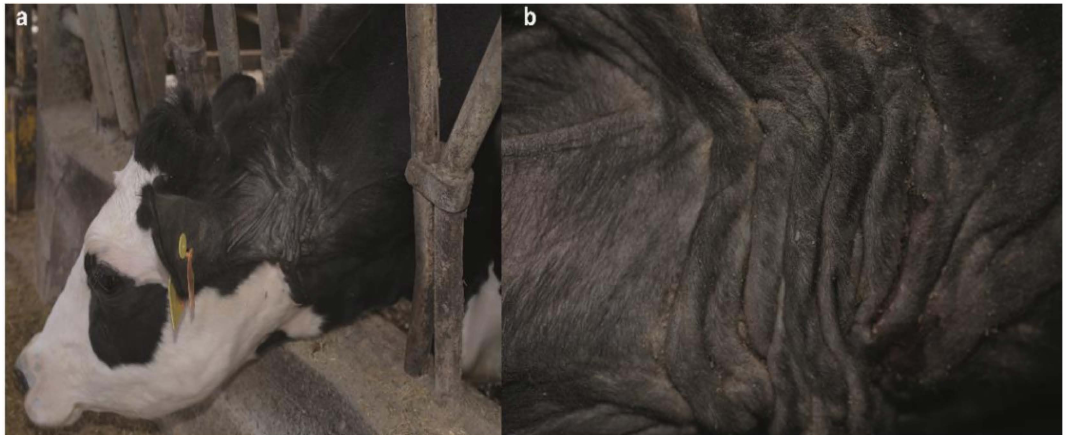
Figure 2. Neck skin lesions of the cEDS-a ff ected Holstein dam. ( a ) Note the multiple wrinkles, folds, papyraceous scars and cutis laxa. ( b ) Details of the neck skin